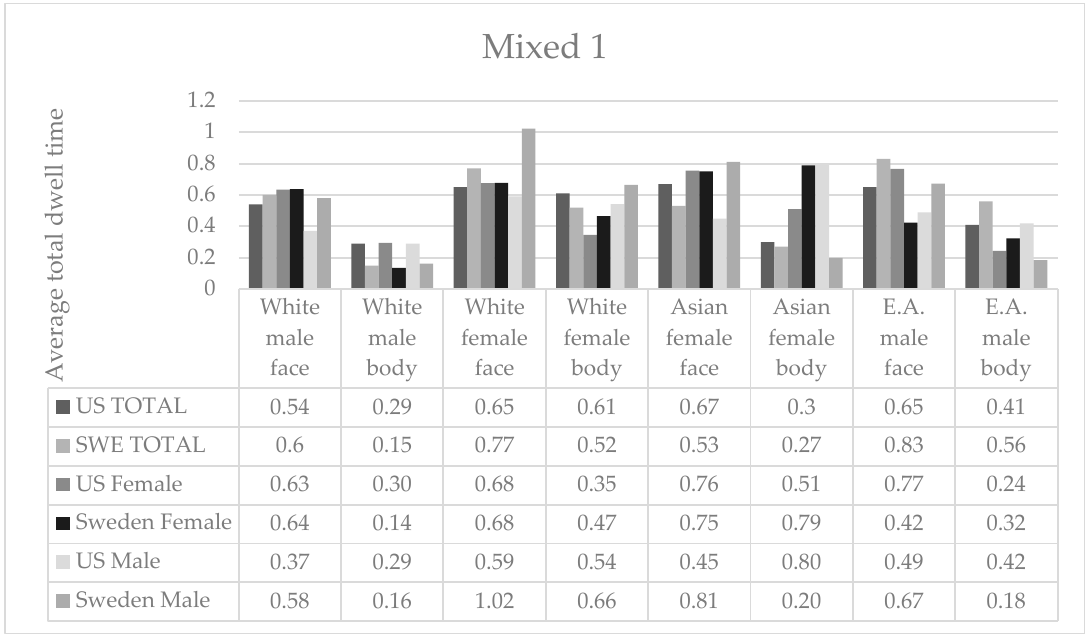
Figure 4. Average total dwell times (s): Mixed 1.